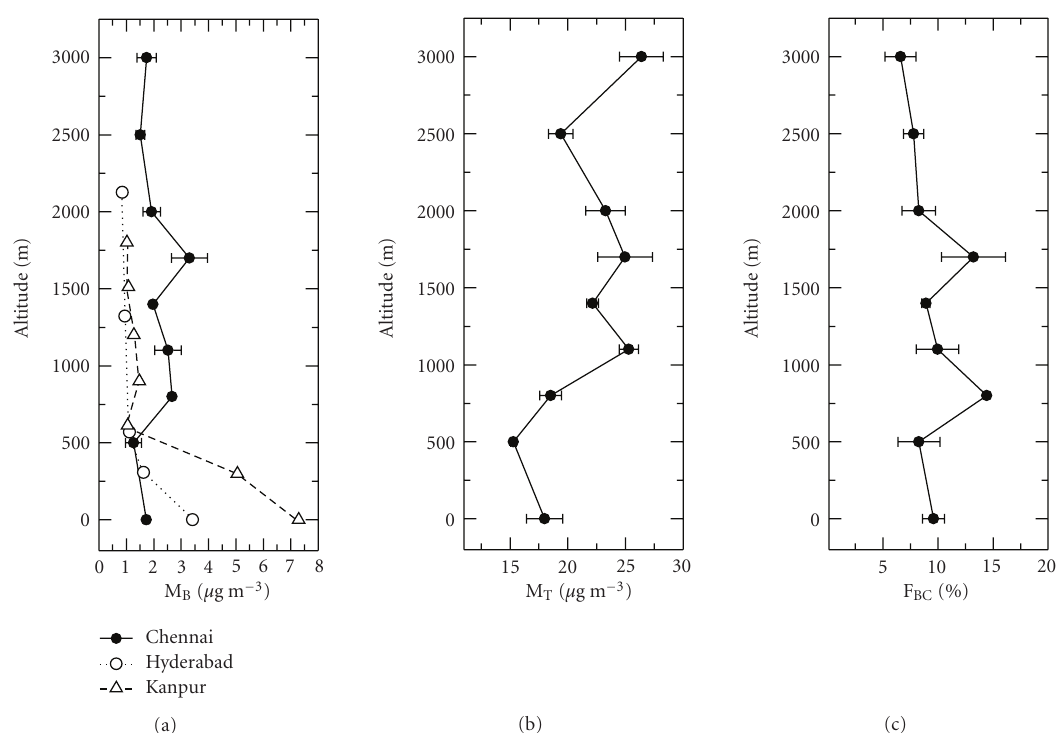
Figure 3: Altitude profiles of M B , M T , and F BC over the coastal oceanic region o ff Chennai. Altitude profile of M B over Hyderabad (circles with dotted line) and Kanpur (triangles with dashed line) are also shown in panel (a) for